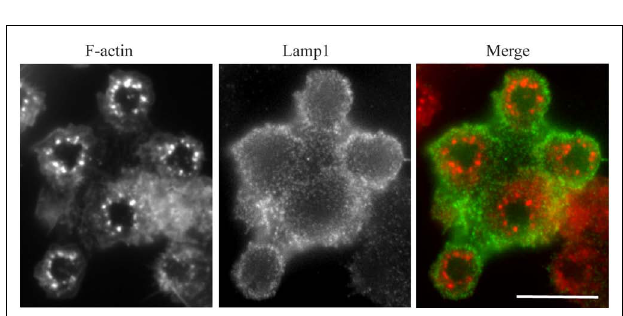
FIGURE 4 | Lamp1 is recruited to the frustrated phagosomes. RAW–GFP cells were added to micro-patterned immune complexes for 10min before being fixed and stained for Lamp1 (red) without cell permeabilization. Actin was visualized thanks to GFP fluorescence (green). Bar = 5 μ